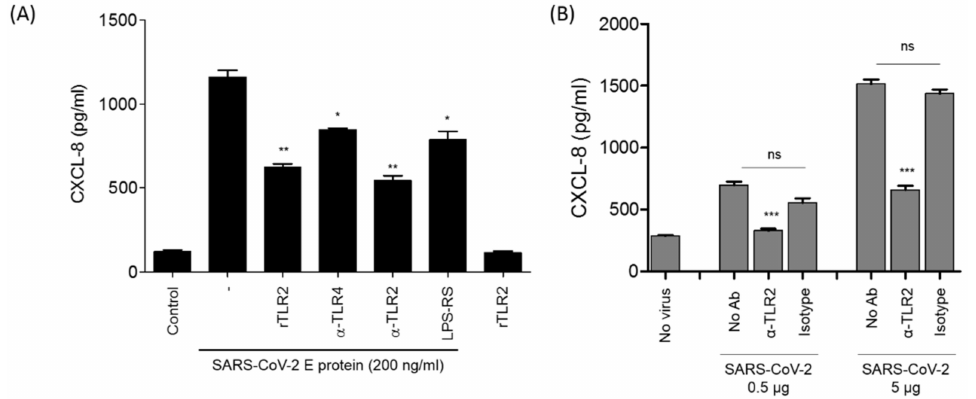
Figure 4. Inhibition of E-induced CXCL8 production by soluble recombinant TLR2 or by anti-TLR2 antibodies. ( A ) The HEK-TLR2 cell line was stimulated with the E protein (200 ng/mL) in the presence or absence of recombinant TLR2 (20 ng/mL), anti-TLR2 and anti-TLR4 antibodies or LPS-RS (10 µ g/mL), and recombinant TLR2 (20 ng/mL) alone was used as a control. ( B ) HEK-TLR2 cells were stimulated with inactivated SARS-CoV-2 (0.5–5 µ g/mL) in the presence of anti-TLR2 antibodies or their isotypes (10 µ g/mL). After 20 h of treatment, the cell supernatant was collected and CXCL8 chemokine production in the cell supernatants was quantified by ELISA. Statistical significance comparing different groups is denoted with * for p < 0.05, ** for p < 0.01 and *** for p < 0.001, while ns means